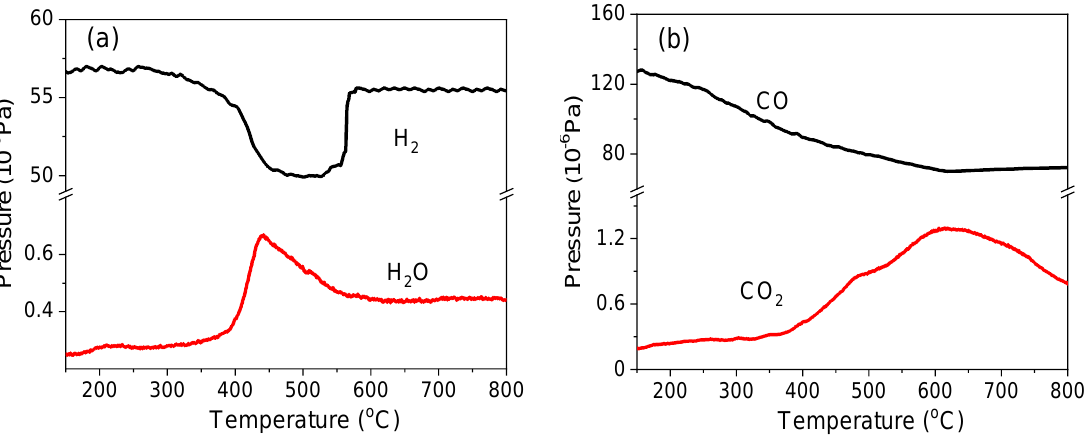
Figure 11. Reduction process of NaCeY sorbent in H 2 ( a ) and CO ( b ) containing atmospheres. Note that the data were obtained by follows: 0.05 g NaCeY was weight in a fixed bed reactor coupled with MS, and then was heated in 10H 2 /CO + 90Ar (vol%) with a flow rate of 50 mL/min from ambient temperature to 800 °C with a heating rate of 2 °C/min.